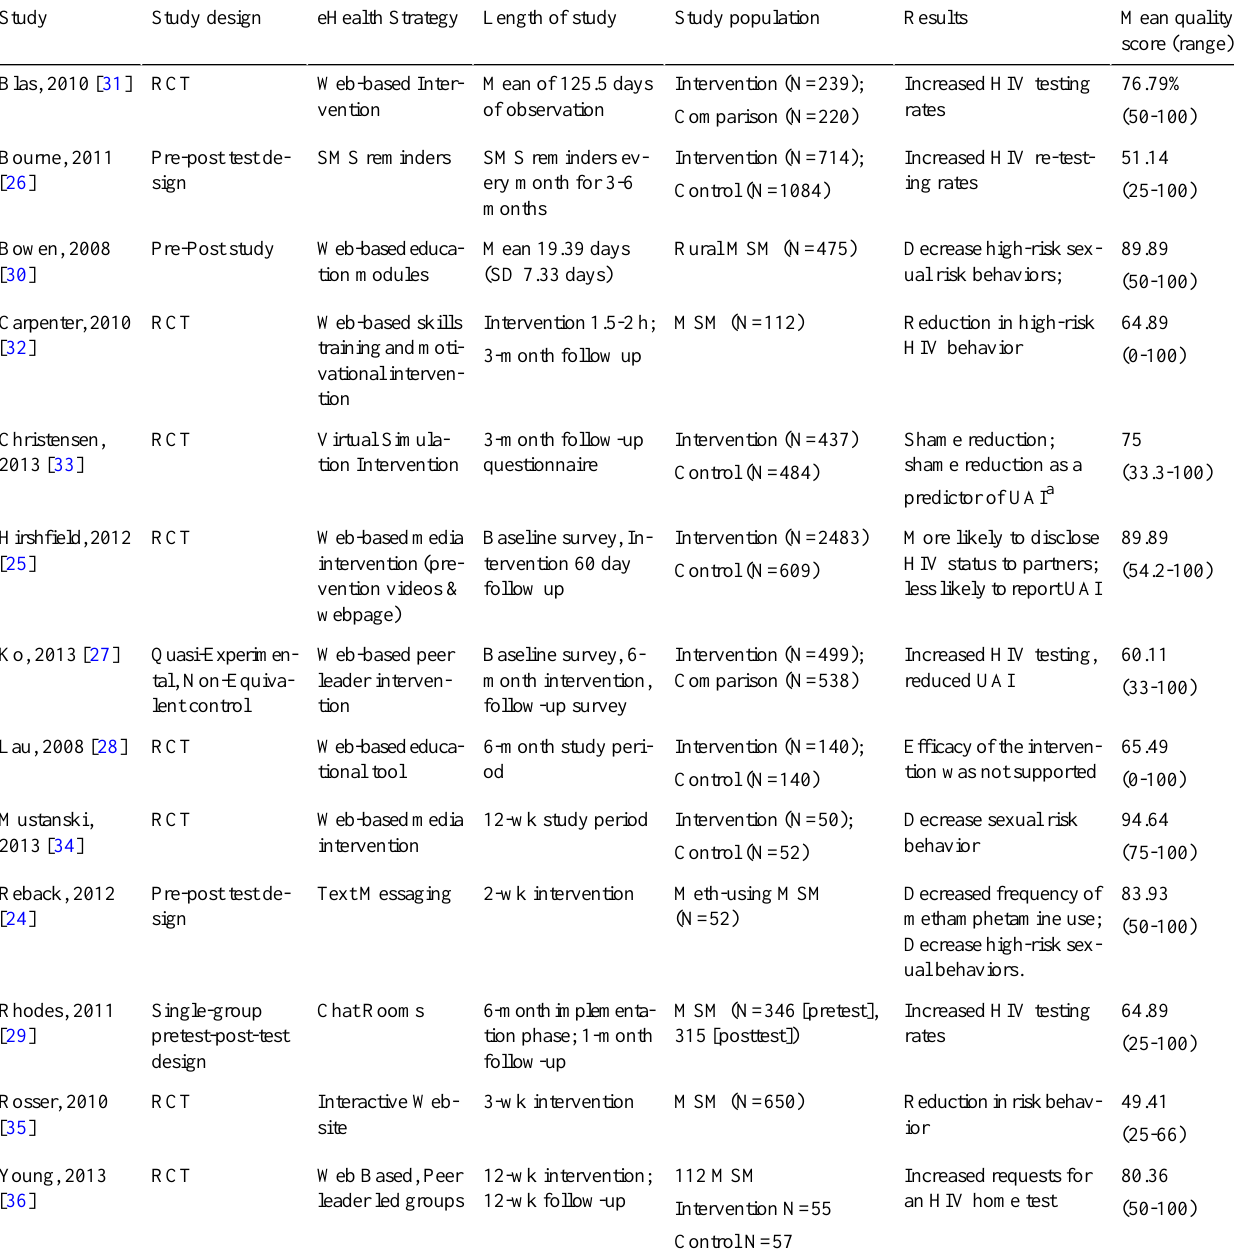
Table 2. Existing studies of eHealth HIV prevention interventions for adult